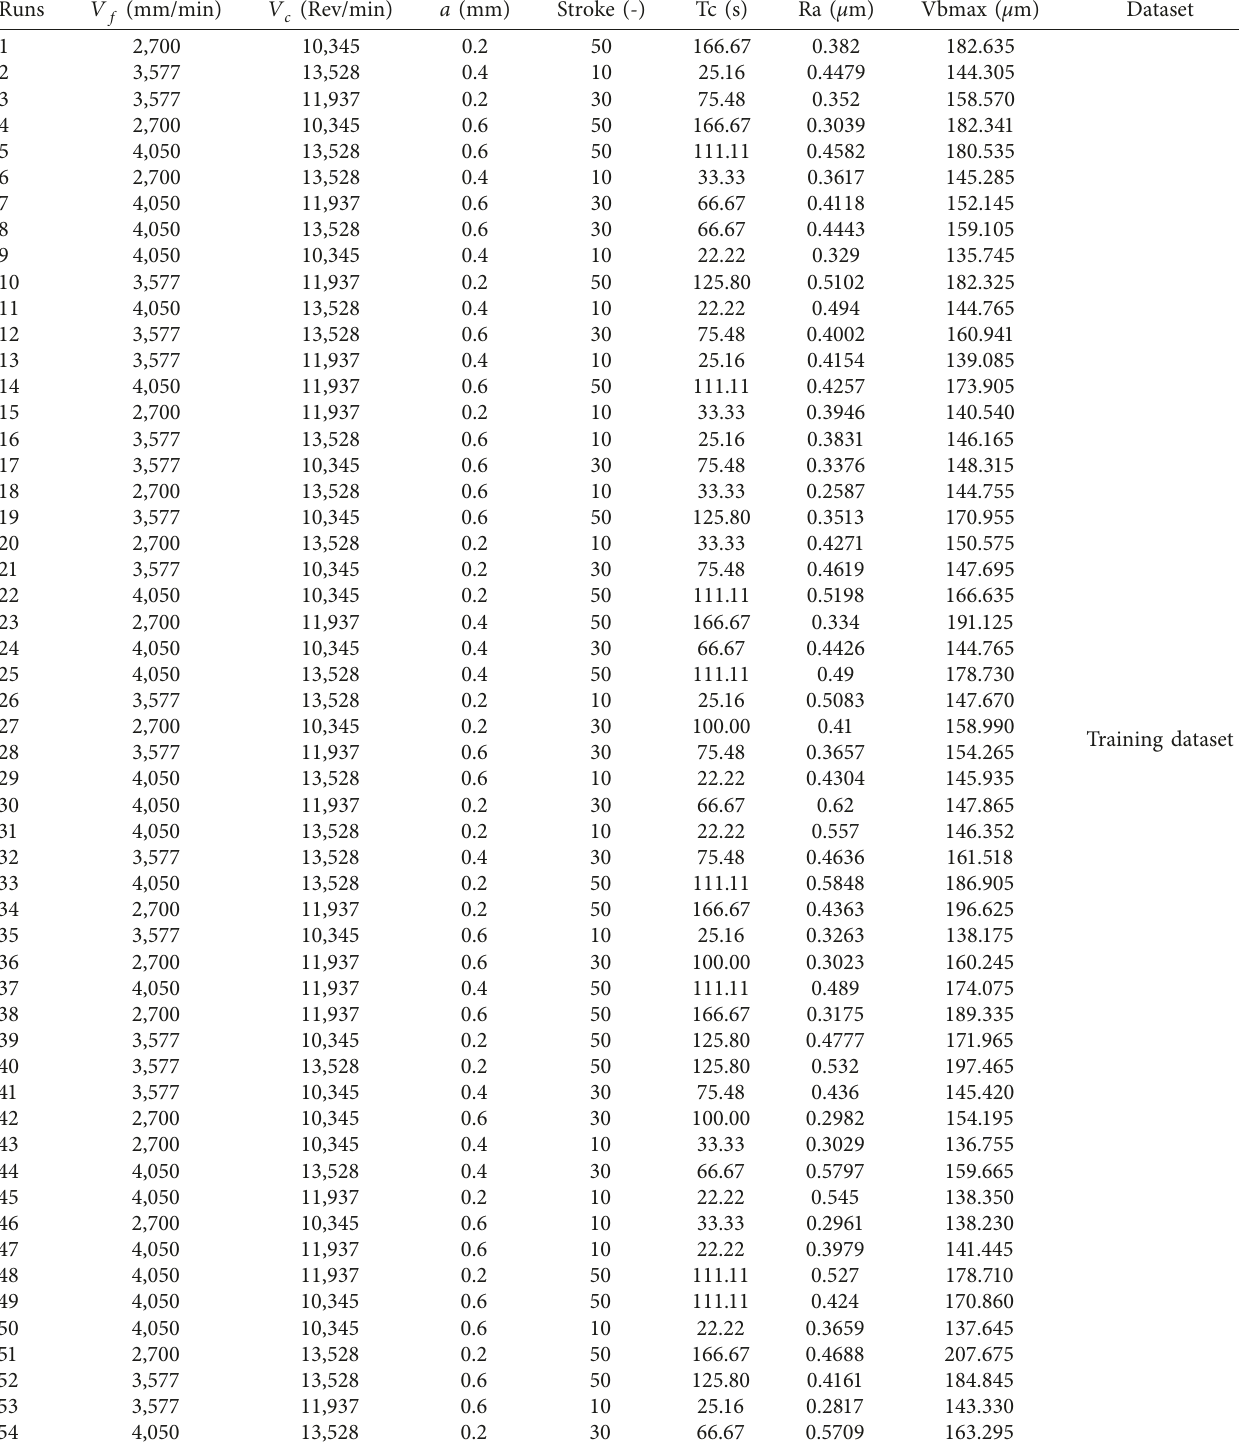
Table 3: Machining parameters employed in the experiment, including training and testing datasets for the training of machine learning